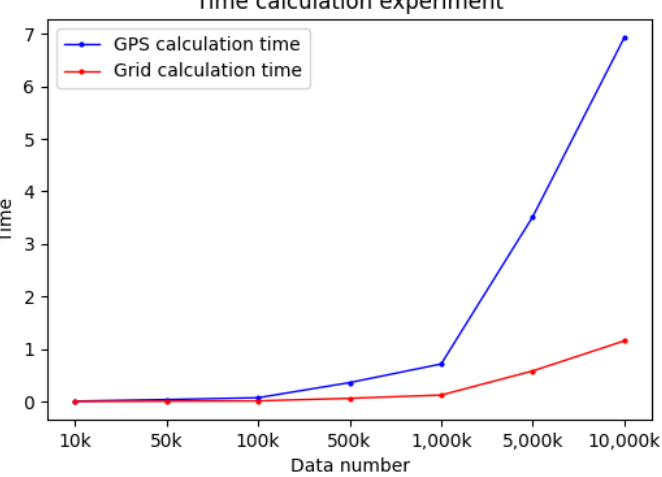
Figure 12. Spatial distance calculation time comparison.